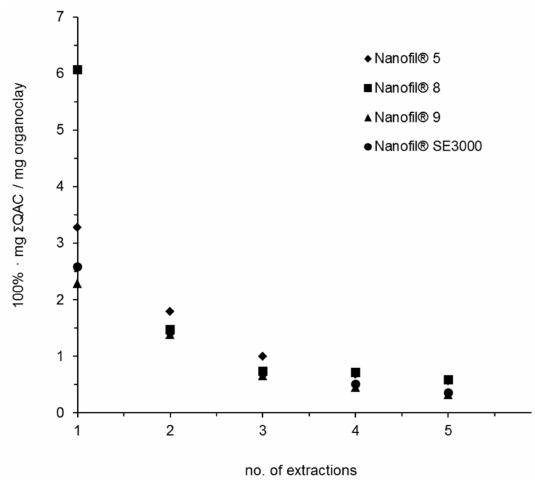
Figure 3. The extraction of total QAC ( Σ QAC) of five consecutive extractions of the organoclays. Each point represents the average of three